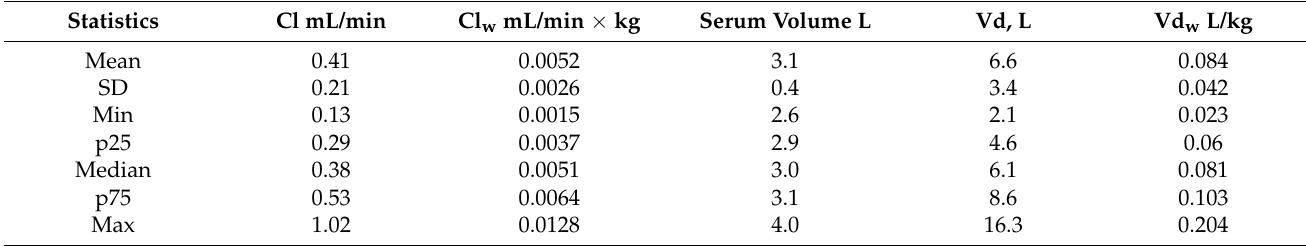
Table 4. cC 6 O 4 renal clearance (Cl) and distribution volume